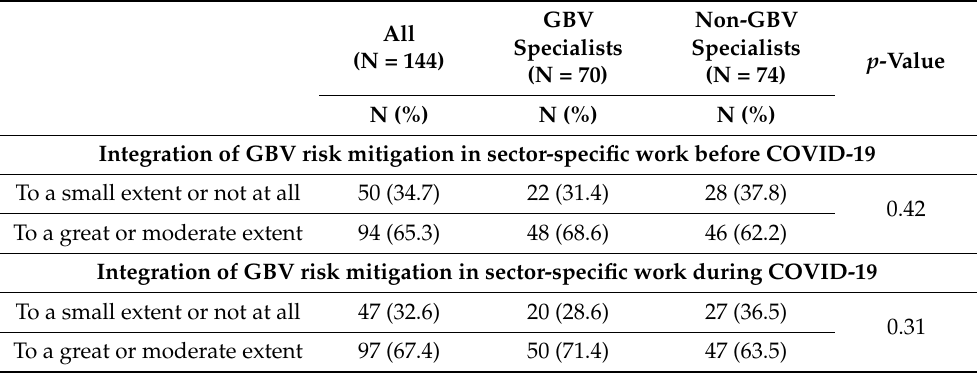
Table 5. Integration of GBV risk mitigation before and during COVID-19.